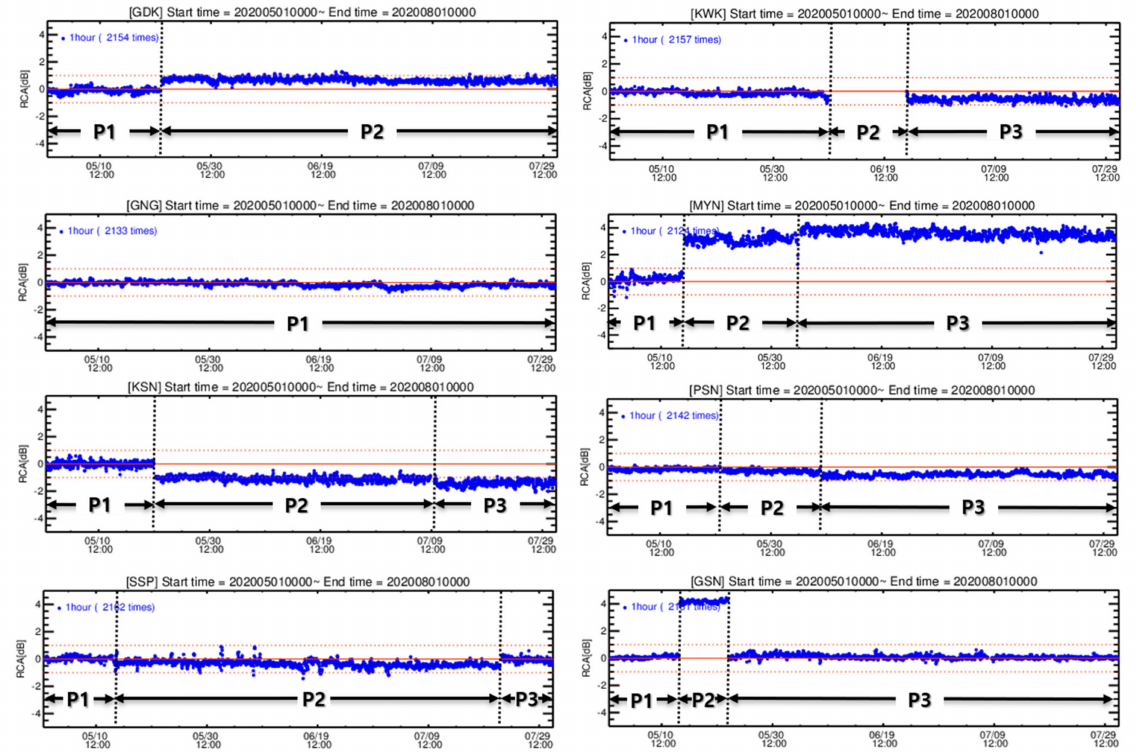
Figure 6. Time series of radar calibration adjustment (RCA) at each radar within the KMA network from 1 May 2020 to 31 July 2020. The P1, P2, and P3 is the period with the similar